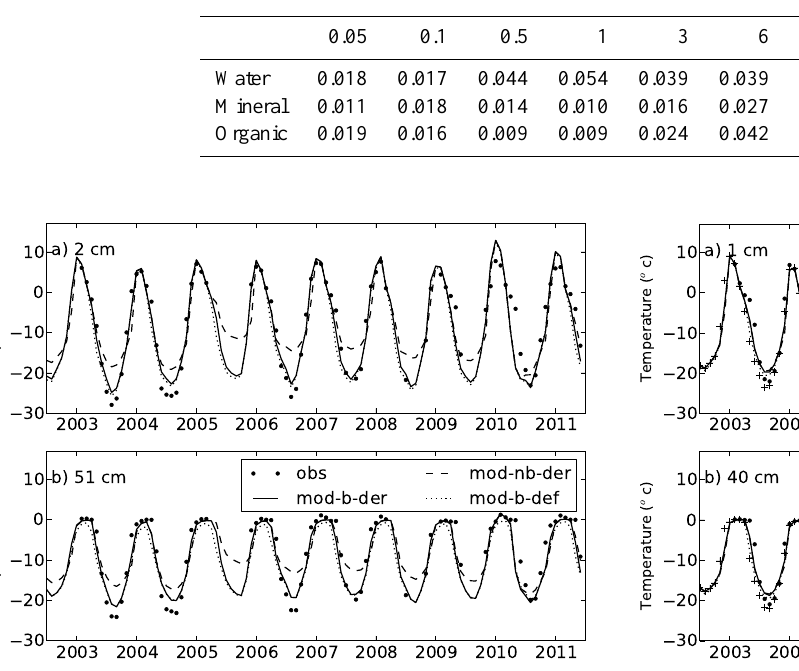
Figure 7. Comparisons of monthly average soil temperatures at 1 and 40cm depths below the center site from simulations (mod), with and without a maximum snow thickness setting (b and nb), us- ing the observed snow thickness (snw-obs), and using derived and default thermal properties (der and def), with those from field mea- surements (obs), over the period from 2003 to